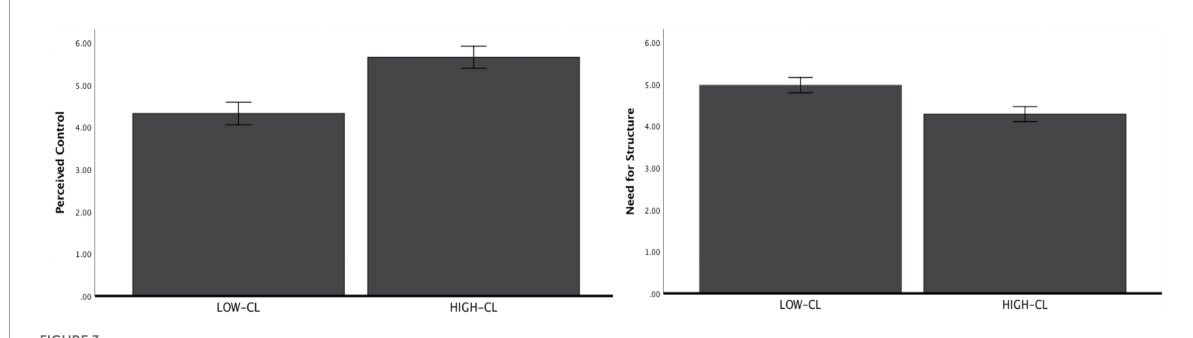
FIGURE3 Perceived control and need for structure as a function of construal level (study 1b).